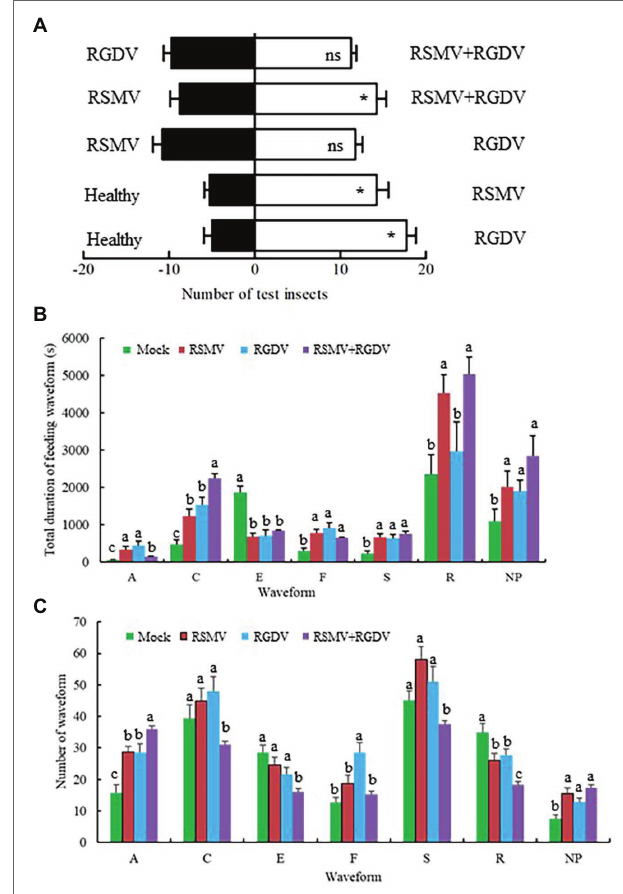
FIGURE 6 | Virus-infected rice plants affected the feeding tendencies and behaviors of non-viruliferous R. dorsalis . (A) The effect of odors emitted by virus-infected rice plants on the feeding tendencies of R. dorsalis . Each experimental group was comprised of 30 adults and was repeated five times in total. Means (±SD) from five biological replicates are presented. * p < .05; ns, not significant. (B,C) Virus-infected rice plants affected the feeding behaviors of non-viruliferous R. dorsalis . The duration of each waveform (B) and number of each waveform (C) for R. dorsalis were analyzed. NP, not probing; A, stylet movement in the tissue; S, intracellular salivation in mesophyll cells; C, active ingestion of the phloem; E, passive phloem sap ingestion; F, obstacle waveform; R, rest waveform; means (±SD) from three biological replicates are presented. Different letters in the same column indicate a significant difference ( p <